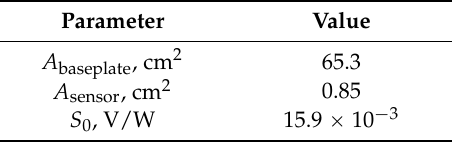
Table 3. Heat flux sensor and IGBT parameters used for the heat flux calculation.